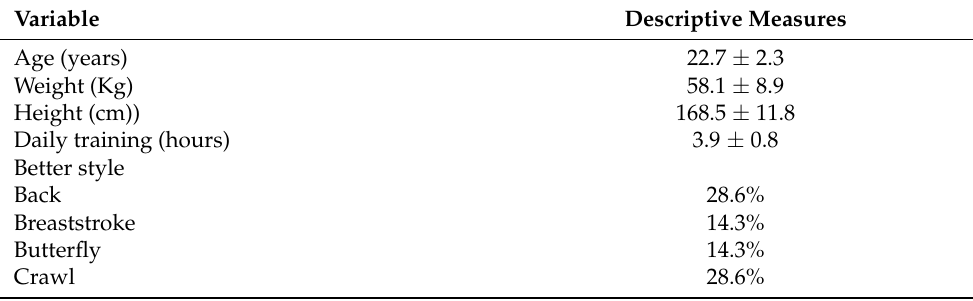
Table 1. Descriptive measures of the secondary variables